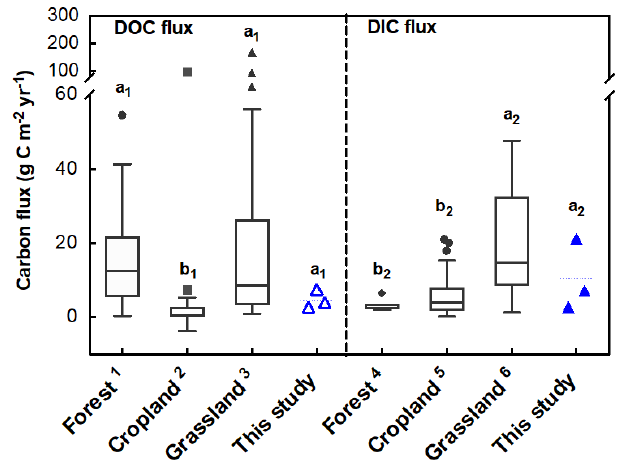
Figure 7. Leaching fluxes of dissolved organic carbon (DOC) and dissolved inorganic carbon (DIC) in this study compared with those reported in the literature. 1 n = 110; data from Brooks et al. (1999), Fröberg et al. (2005, 2006, 2011), Gielen et al. (2011), Kindler et al. (2011), Lu et al. (2013), Michalzik et al. (2001), Sanderman et al. (2009). 2 n = 33; data from Brye et al. (2001), Kindler et al. (2011), Siemens et al. (2012), Walmsley et al. (2011), Wang and Alva (1999), Gerke et al. (2016), Herbrich et al. (2017), Rieckh et al. (2014), Lenz (2014). 3 n = 46; data from Brooks et al. (1999), Brye et al. (2001), Ghani et al. (2010), Kindler et al. (2011), McTier- nan et al. (2001), Parfitt et al. (2009), Sanderman et al. (2009), Tip- ping et al. (1999). 4 n = 8; data from Kindler et al. (2011). 5 n = 32; data from Kindler et al. (2011), Siemens et al. (2012), Walmsley et al. (2011), Wang and Alva (1999), Gerke et al. (2016), Herbrich et al. (2017), Rieckh et al. (2014), Lenz (2014). 6 n = 9; data from Brye et al. (2001), Kindler et al. (2011). Lowercase letters ( a 1 , b 1 and a 2 , b 2 ) represent significant difference levels of DOC and DIC fluxes, respectively, in different ecosystems determined by Dun- can’s multiple range test (one-way ANOVA, p <0.05). Dashed lines represent mean values for the investigated